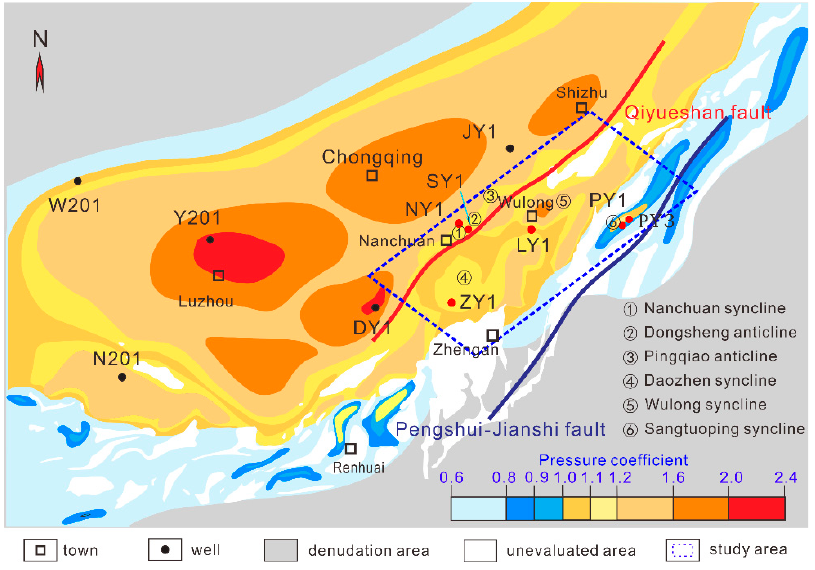
Figure 11. Buried curve of the Longmaxi Formation in southeast Chongqing. ( A ): well PY1, ( B ): well LY1.